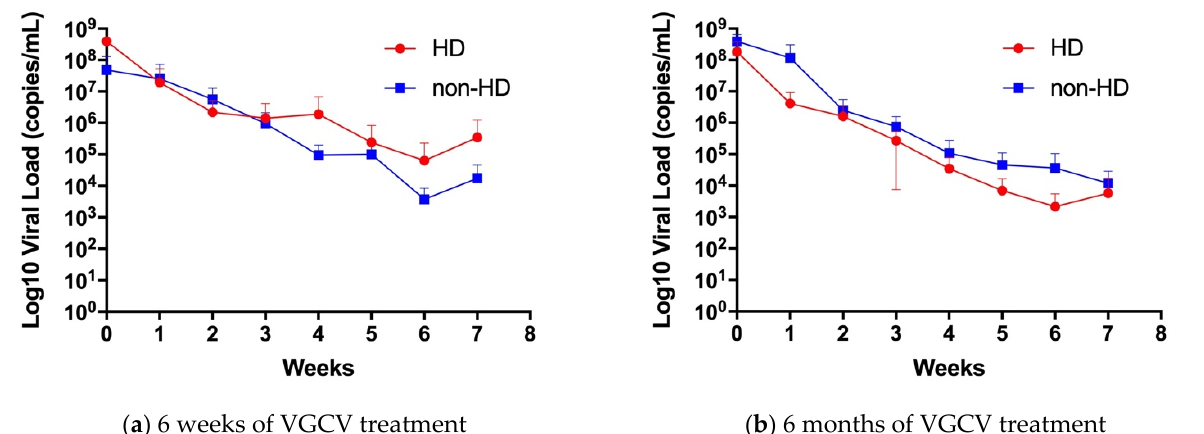
Figure 2. CMV viral load change in urine of ( a ) 6 weeks or ( b ) 6 months of VGCV treatment groups. ( a ) Urine viral load change over 6 weeks of VGCV treatment, n = 7 in HD group, and n = 4 in non-HD group. ( b ) Urine viral load change over 6 months of VGCV treatment, n = 5 in HD group (1 missing data in week 7), and n = 4 in non-HD group (2 missing data in week 7). Red circle symbols represent HD group and Blue square symbols represents non-HD groups. Data are shown as mean ± standard deviation. HD; hearing dysfunction, non-HD; non-hearing dysfunction.